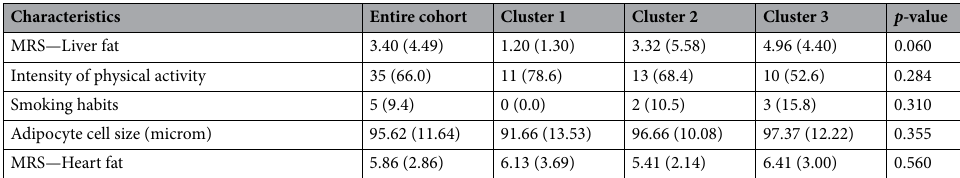
Table 1. Baseline characteristics for all study participants including 3 unique clusters that were identified through k-means clustering